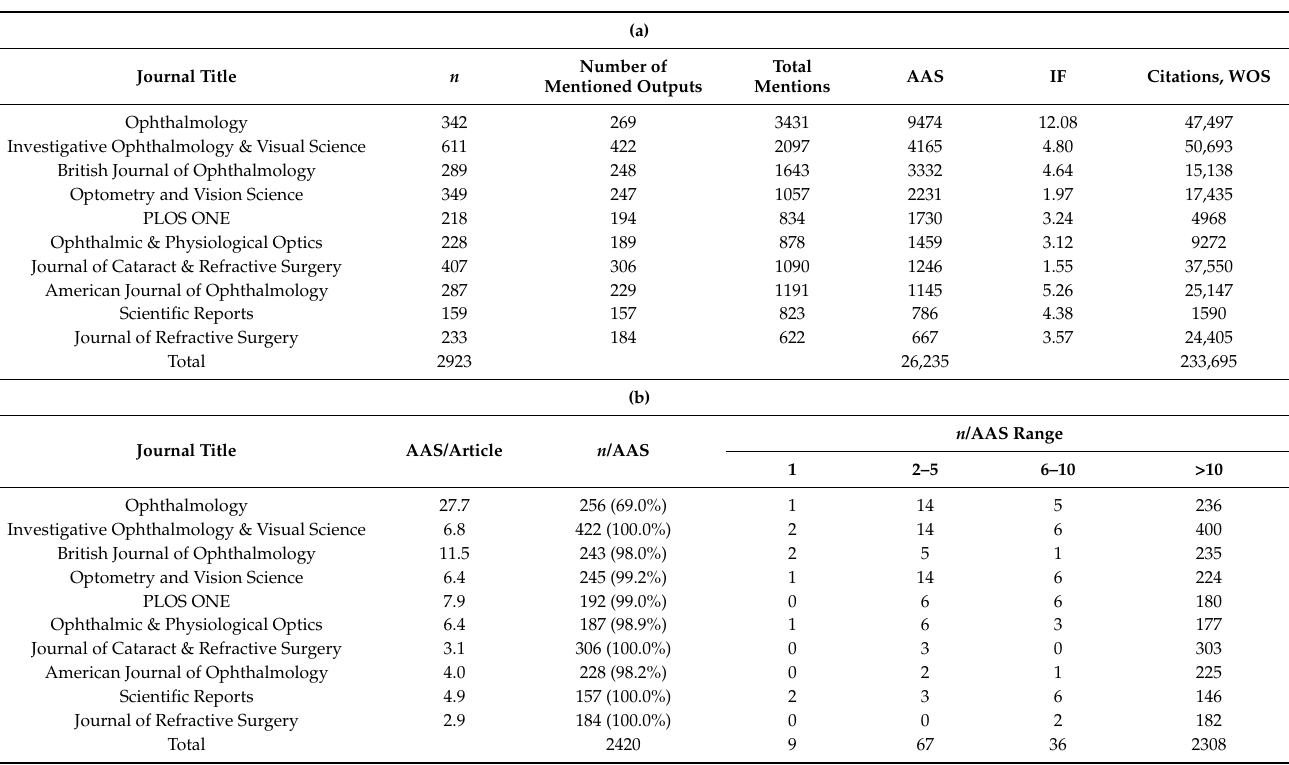
Table 4. Journals in the top-10 Altmetric Attention Score in myopia research (a) and AAS rank for each of the journals studied (b).